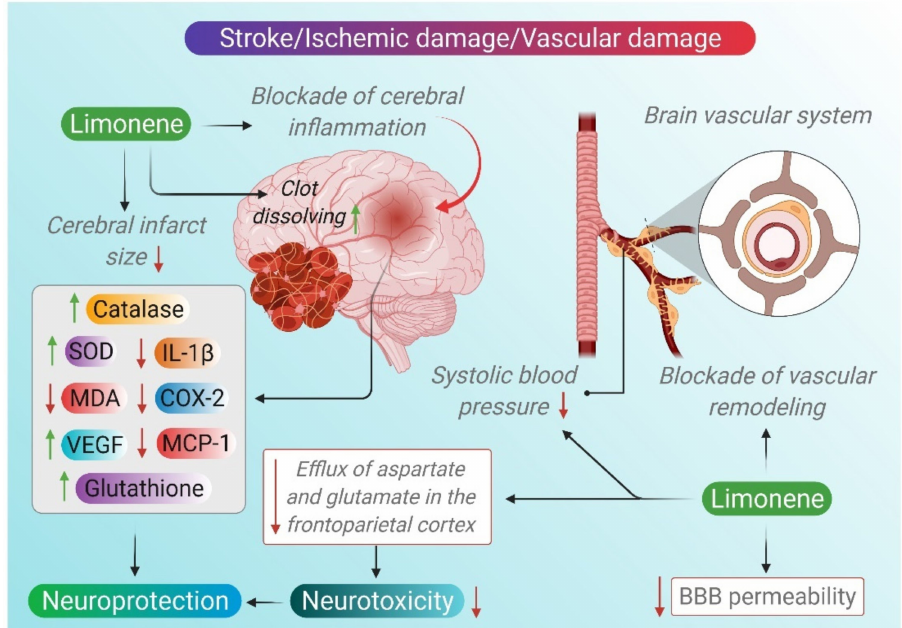
Figure 4. Neuroprotective mechanisms of limonene in cerebrovascular